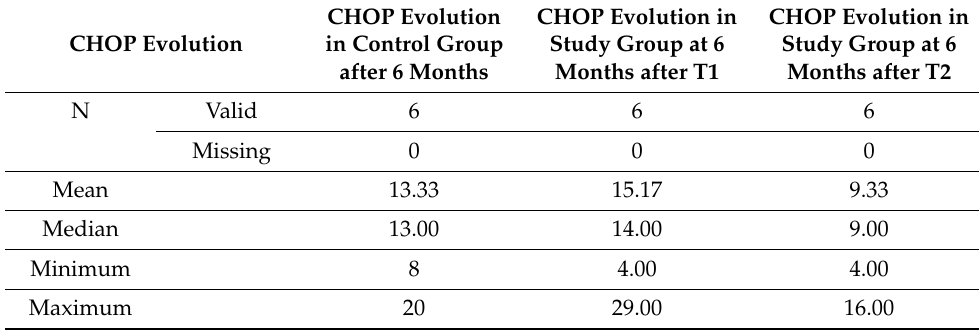
Table 3. CHOP-INTEND score evolution 6 months after therapy initiation for both groups.